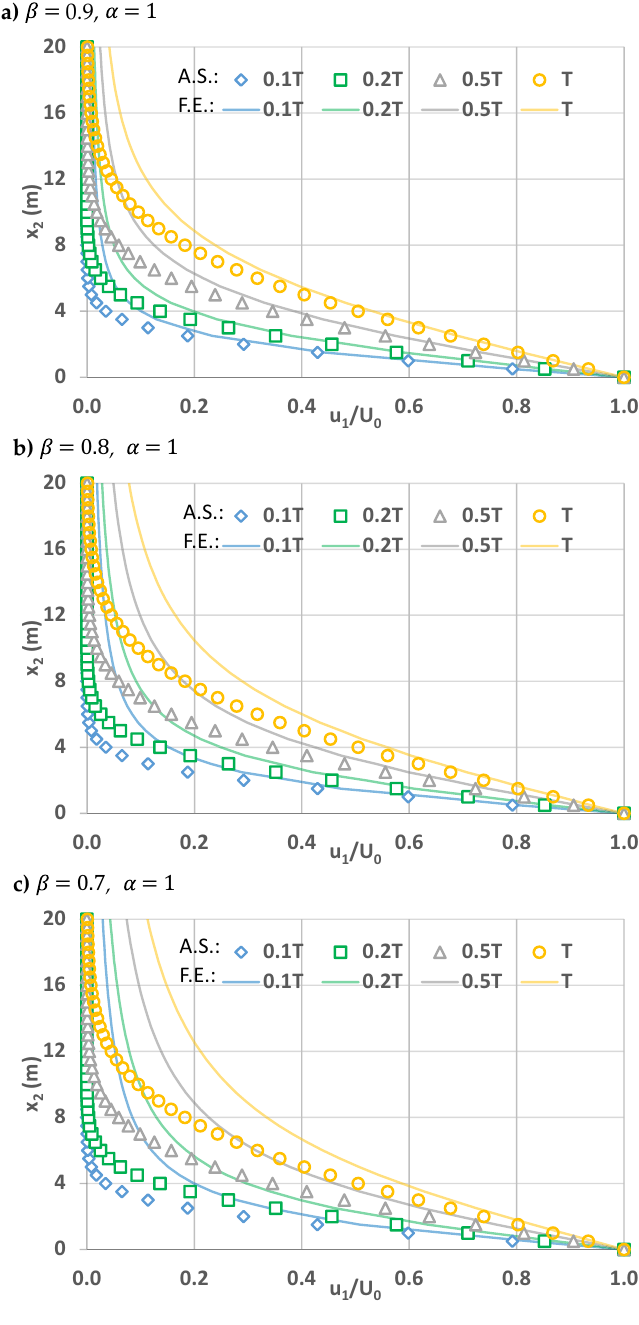
Figure 5. Velocity profiles of x 1 direction velocity u1 normalized by boundary velocity U 0 when time and space fractional derivative powers α = 1 and ( a ) β = 0.9, ( b ) β = 0.8, ( c ) β = 0.7 simulations by the fractional governing equation (F.E.) when time t = 0.1 T, 0.2 T, 0.5 T¸ T. Shapes (diamond, square, triangle, and circle) represent the analytical solutions (A.S.) of the conventional governing equation at corresponding